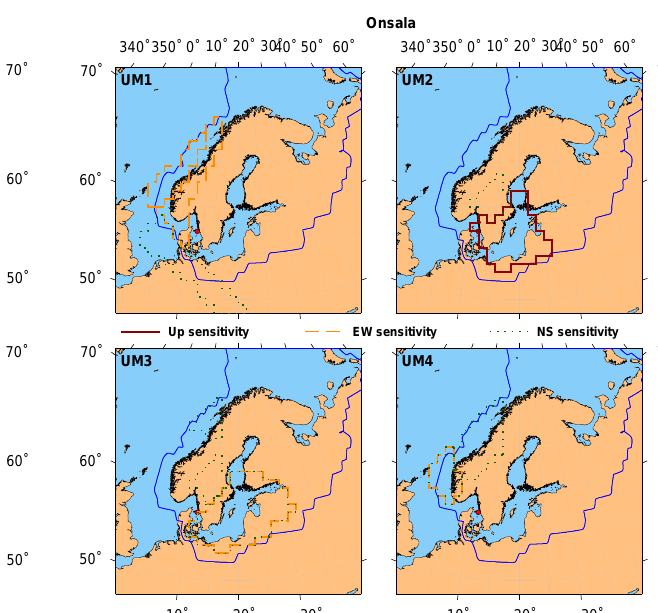
Fig.8. SameasFig.4,butforOslo. Figure 8. Same as Fig. 4, but for Oslo.